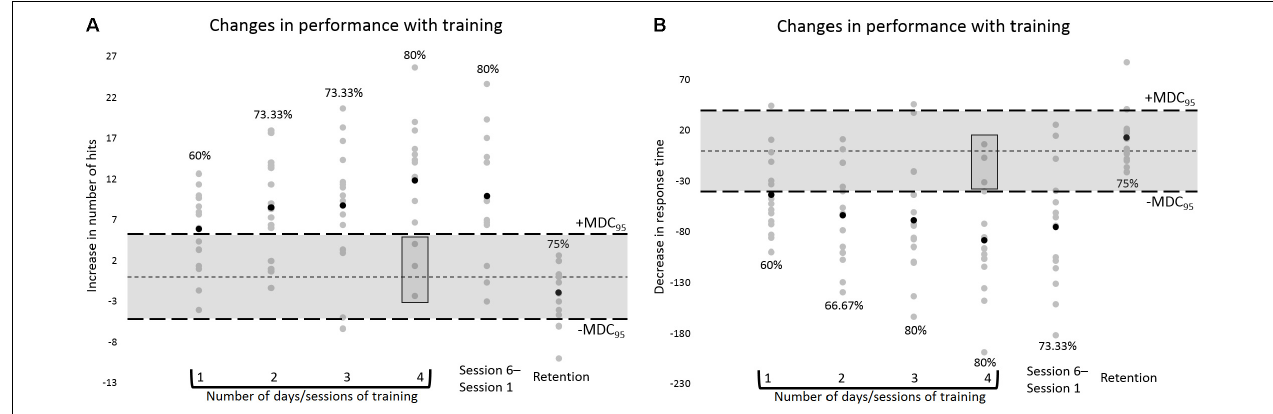
FIGURE 5 | The same type of data as in Figure 4 are displayed, but here data are displayed at the individual level. The percentages represent the MDC 95 proportions. These values correspond to the percentages of participants showing motor learning during the training period, i.e., showing an improvement in performance that was equal to or greater than the absolute values of the MDC 95 and that therefore was outside the range of random measurement error, and hence was likely to have been caused mostly by learning. The rectangular boxes highlight the participants displaying a change in performance at the end of the training period, i.e., after 4 days/sessions of training, that was smaller than the absolute values of the MDC 95 . These individuals could be considered “non-learners.” The percentages at Retention represent the percentages of participants who, having displayed motor learning at the end of the training period, showed a change in performance at the 1-week long-term retention test (Session 5 to 6) that was smaller than the absolute values of the MDC 95 and that therefore was likely to have been caused mostly by random measurement error.